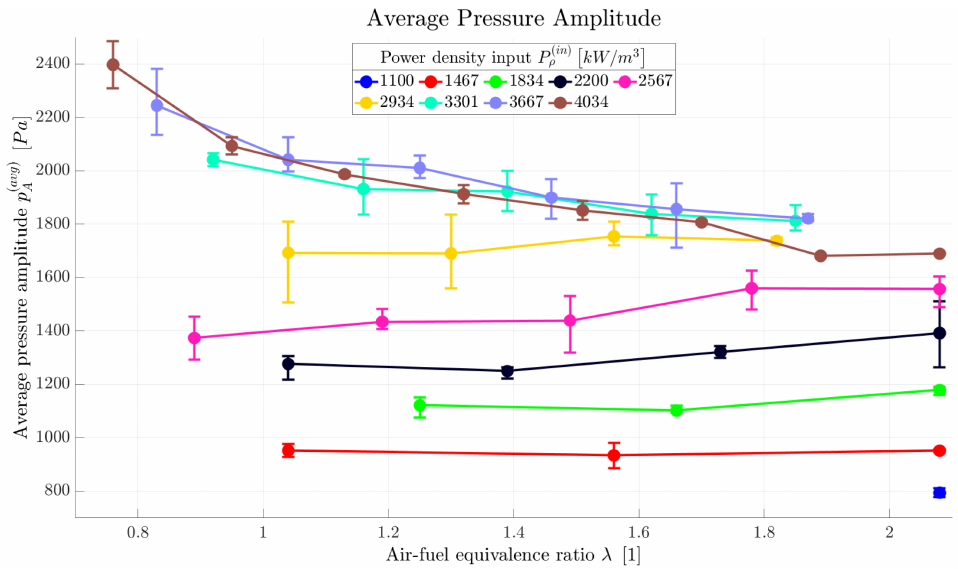
Figure 12. Average tailpipe pressure amplitude displayed relative to air–fuel equivalence ratio for several power density input